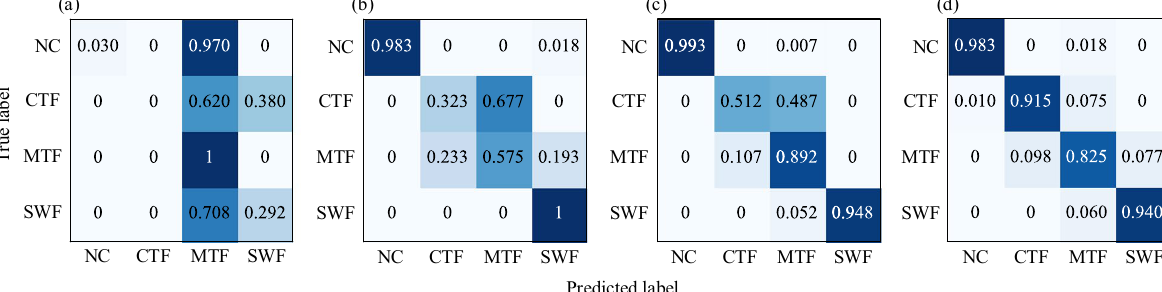
Fig. 11 The confusion matrices for the transfer results of the dataset A 1 : ( a ) CNN, ( b ) DANN, and ( c ) DTLN-T, ( d )